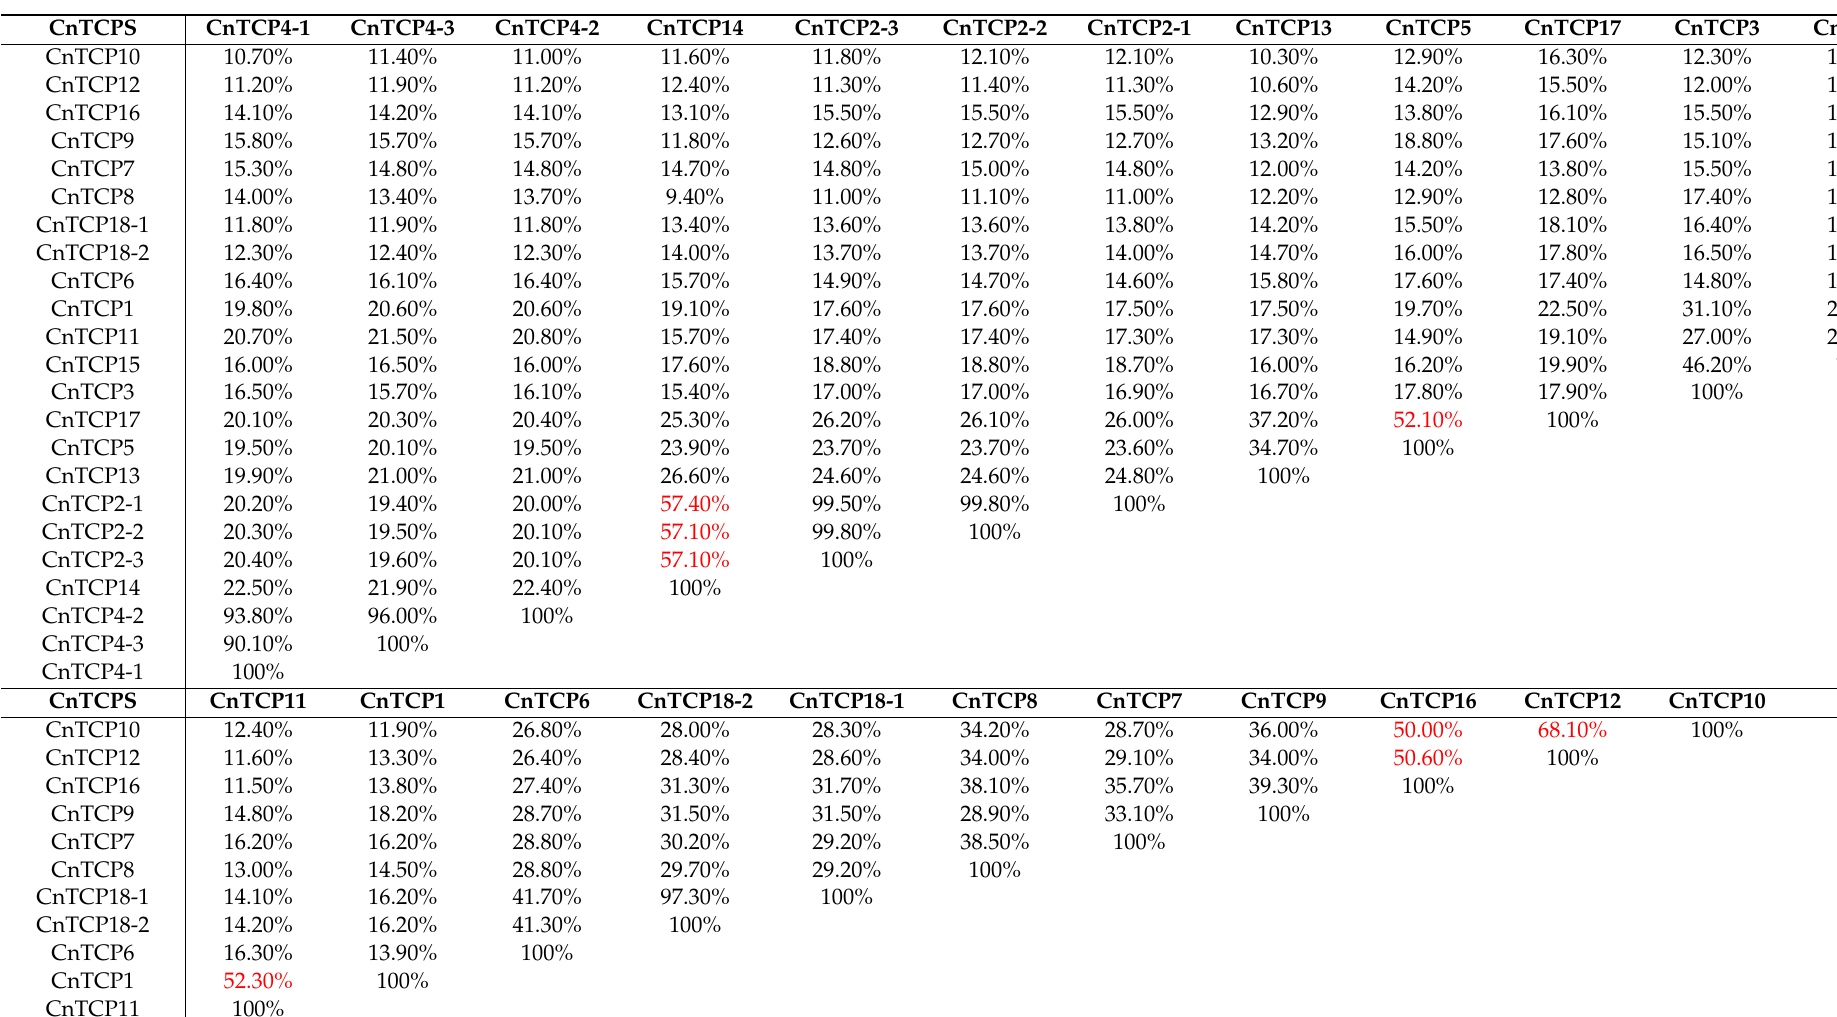
Table 1. Percentage homology among full-length CnTCPs